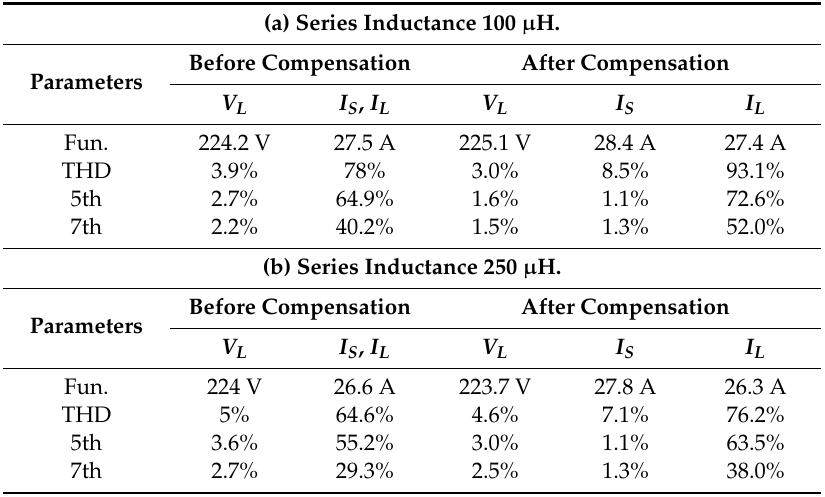
Table 3. Experimental